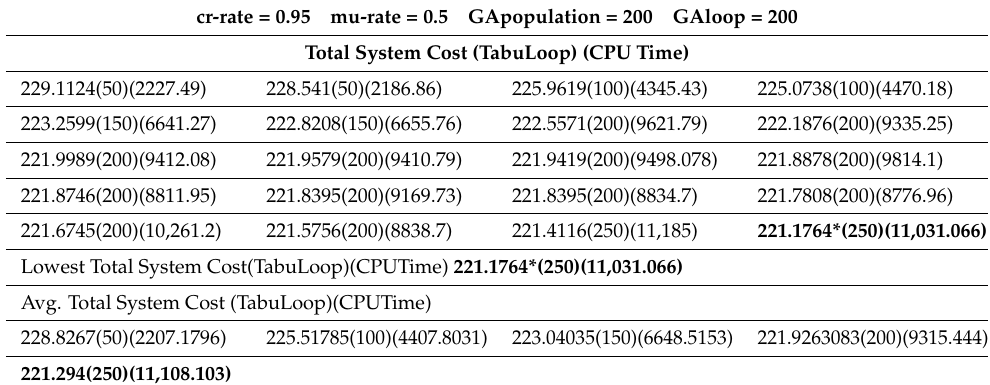
Table 37. The total system costs of 20 simulation runs acquired by TA–MGA combined method for the n -stage mixed system.